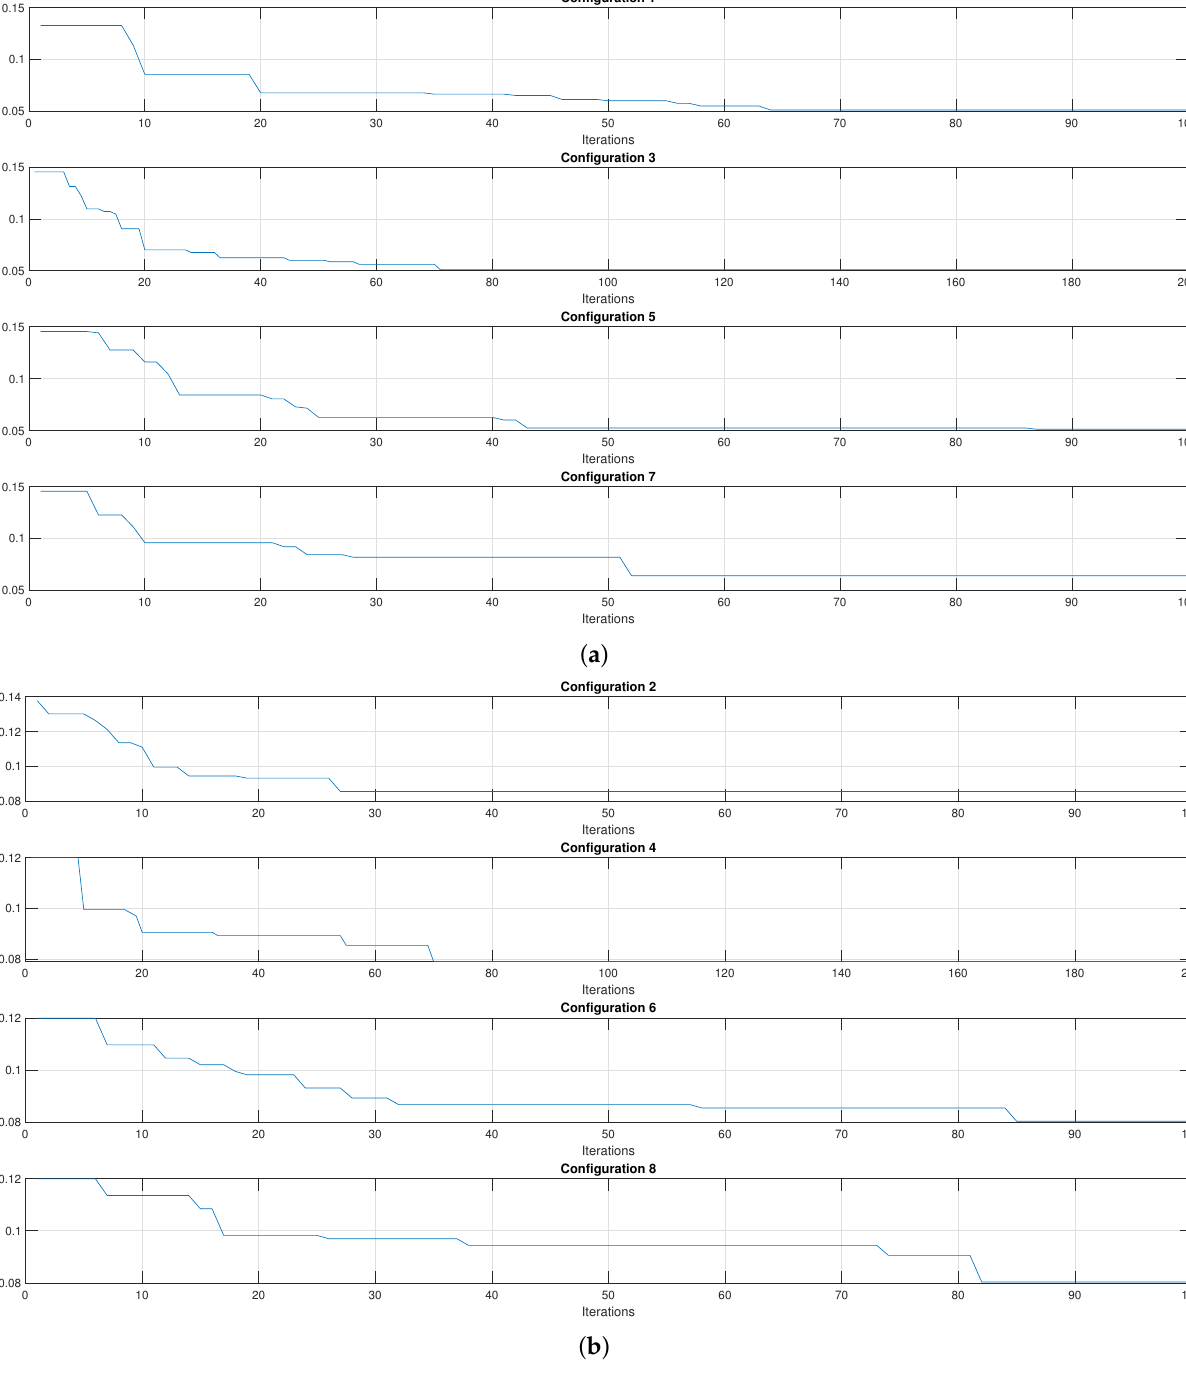
Figure 10. Plot of the classification percentage as a function of the number of iterations for ( a ) the Gaussian kernel and ( b ) the linear